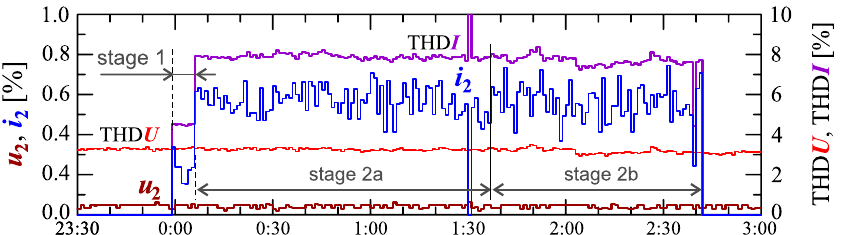
Figure 18. The characteristics of the voltage THD factor THD U = f ( t ) and current THD factor THD I = f ( t ) and the characteristics of the second harmonics of the current i 2 = f ( t ) and voltage u 2 = f ( t ) for Case II.